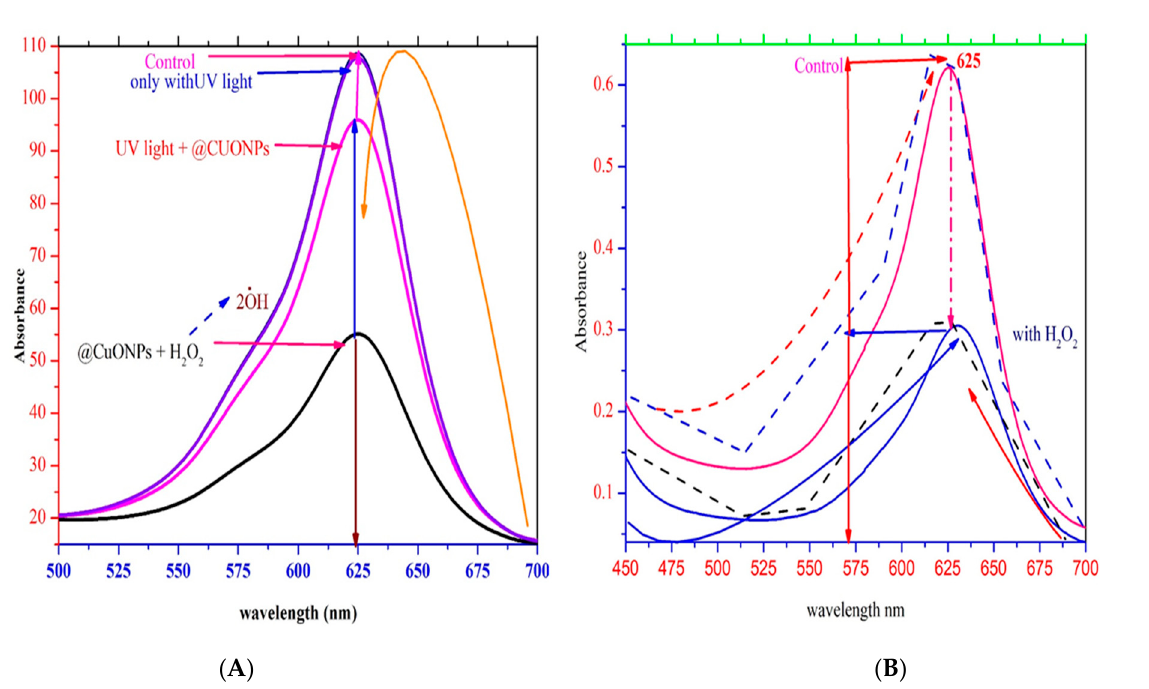
Figure 10. Photo dilapidation of CR dye: ( A ) Effect of light control, light effect, light and @CuONPs and @CuONPs and H 2 O 2 effect; ( B ) Effect and comparison of H 2 O 2 on the degradation of Congo red dye.